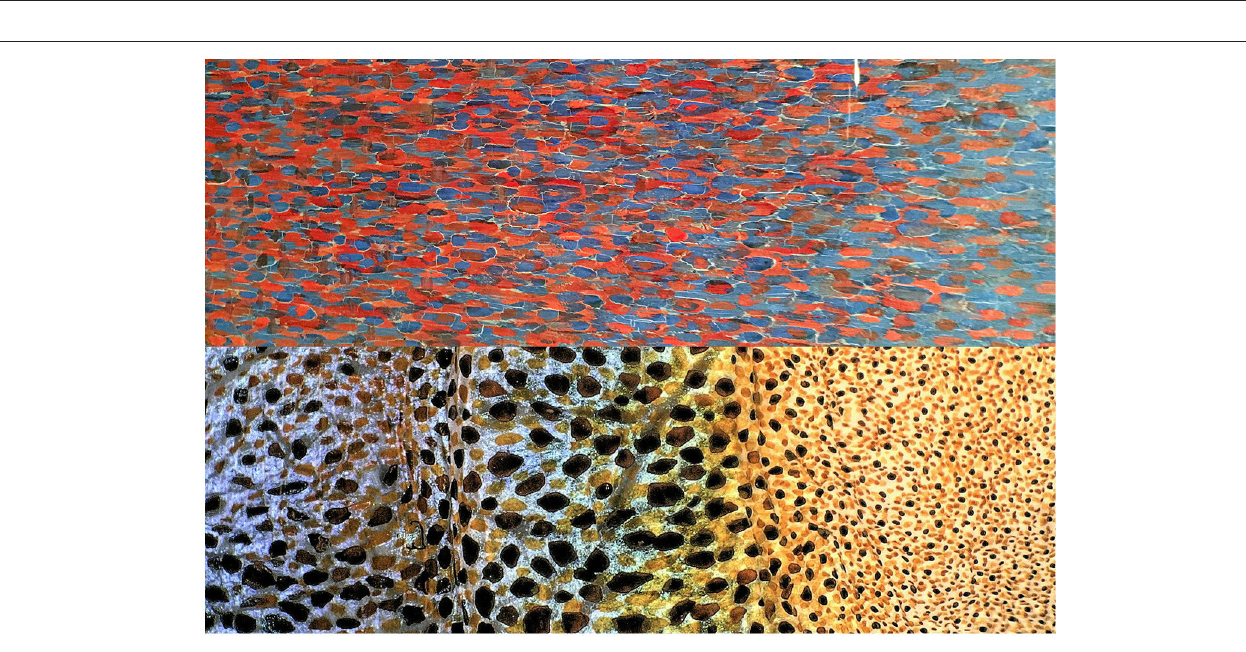
FIGURE 6 | Image comparison of detail close up of painted frame of Georges Seurat’s painting View of Le Crotoy from Upstream (1889), oil on canvas, collection of Detroit Institute of Arts (Top) and octopus skin (Bottom) showing the dense distribution of chromatophores and iridophores. Note: (1) A momentary flash of an anesthetized octopus multi-color skin that was taken with a next-generation KEYENCE digital VHX900F microscope and a 20Å ∼ greater depth-of-field VH-Z00R lens under a multi-angle observation. Photographed by S. Shigeno. (2) The detail of Seurat’s painting frame was photographed by R. Nakajima at Detroit Institute of Arts in